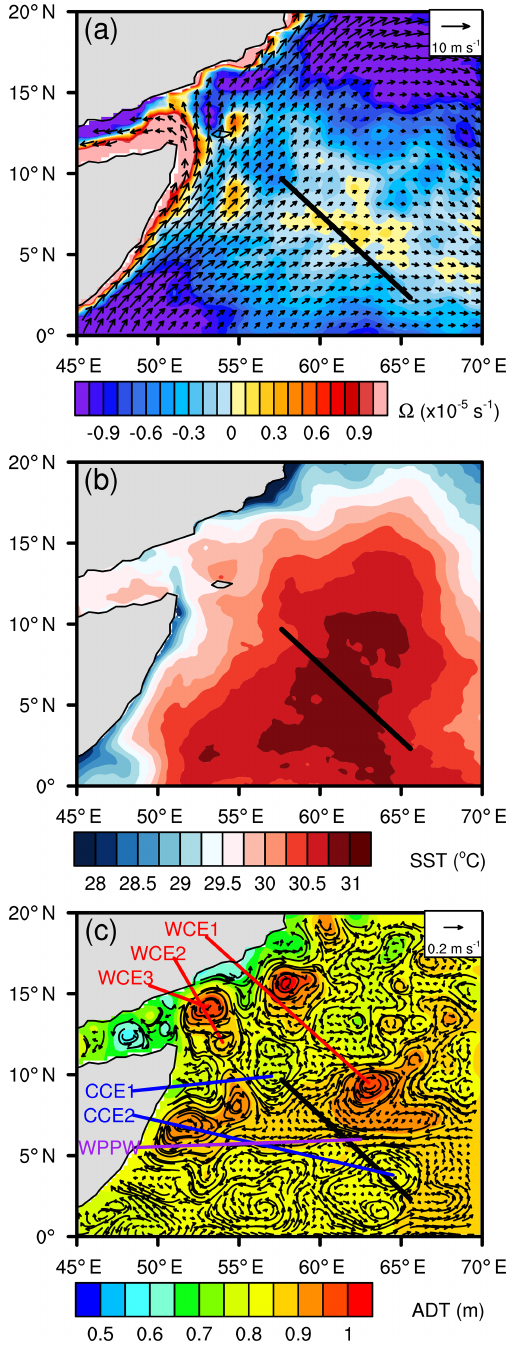
Figure 2. (a) Monthly mean wind vector and vorticity ( (cid:127) ) from CCMP wind data; data are plotted every three points for wind vec- tor; (b) monthly mean sea surface temperature from OSTIA data; and (c) monthly mean sea surface height (absolute dynamic topog- raphy) and the corresponding surface geostrophic current (shown with every two points) from AVISO. The month of May 2012 is considered.